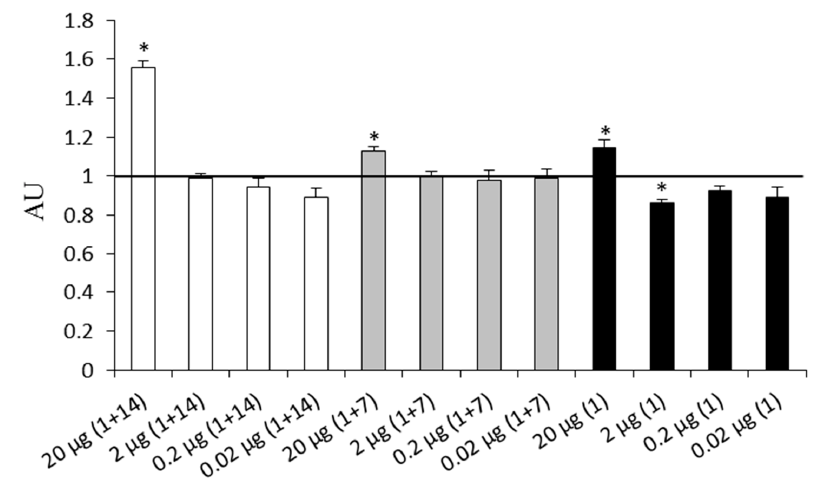
Figure 1. Effects of different doses of OmpF-EIII and different schemes of immunization on the content of anti-OmpF-EIII antibodies in mice blood sera. X -axis: Experimental groups of animals injected subcutaneously once (1), or twice at an interval of 7 days (1 + 7) or 14 days (1 + 14), with OmpF-EIII at doses of 20, 2, 0.2, or 0.02 µ g/mouse. The experiment was terminated 28 days after the first immunization. Each experimental group included ten mice. The control group included mice injected with phosphate-buffered saline (PBS) containing 0.125% n -octylglucoside. The content of antibodies was evaluated by enzyme-linked immunosorbent assay (ELISA), and expressed as the ratio between the absorption in experimental groups and the control value equal to 1 (the horizontal line) ( Y -axis). Data are presented in arbitrary units (AU). The dilution of mouse blood serum was 1/800. Bars represent mean ± SE. * p < 0.05 as compared with the control.